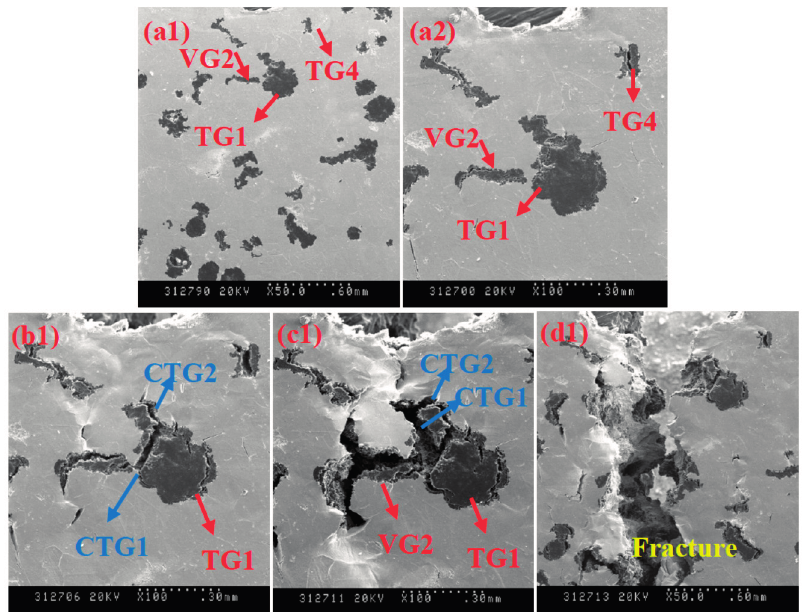
Figure 9. The crack process of temper graphite in heavy section ductile iron. ( a1 ) and ( a2 ): the stretch of specimen is 2.1 mm; ( b1 ): the stretch of specimen is 2.25 mm; ( c1 ): the stretch of specimen is 2.45 mm; ( d1 ): the stretch of specimen is 2.79